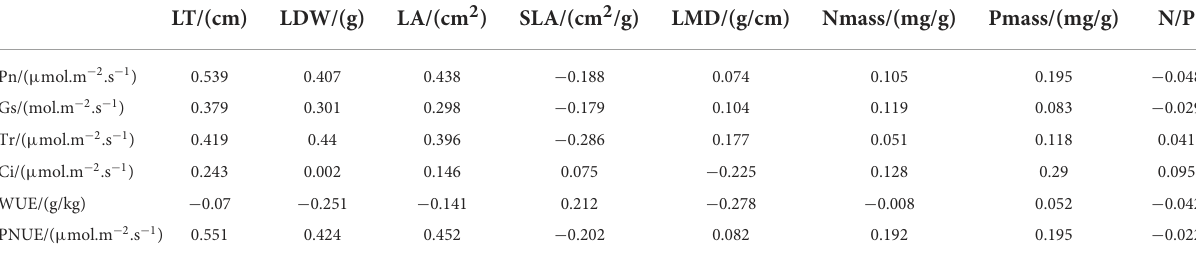
TABLE 6 Correlation between photosynthetic and structural characters of